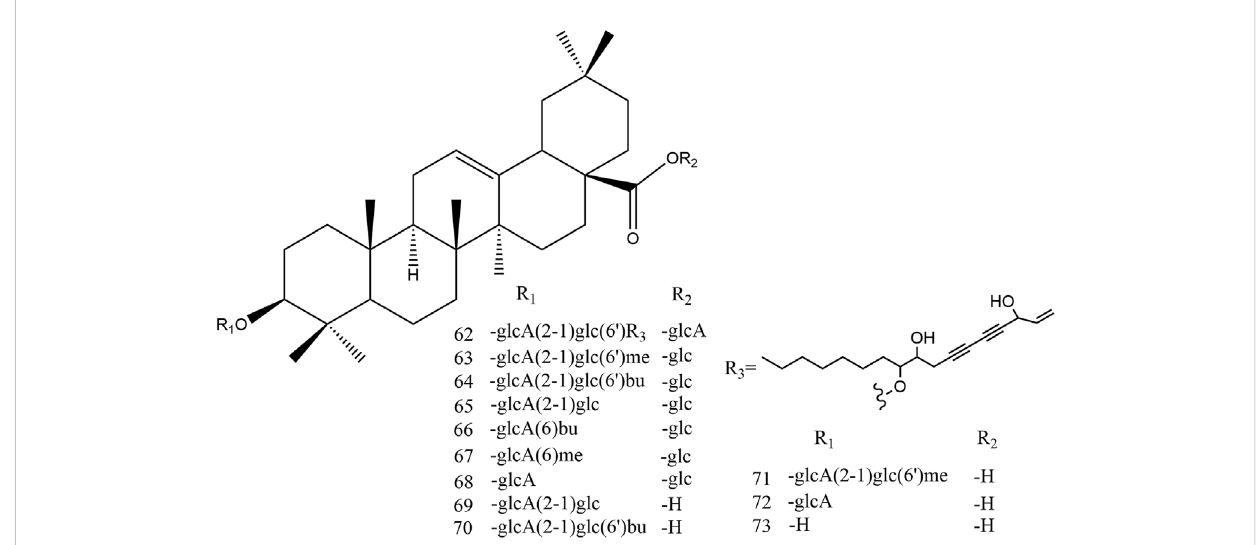
FIGURE 5 Structure of oleanolic acid ginsenosides. (glcA: β -D -glucuronosyl; glc: β -D -glucopyranosyl; me: methyl; bu: